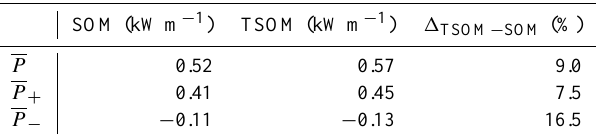
Table 4. Application of TSOM: assessment of the longshore flux of wave energy in shallow-water P . P is the mean over the 1979–2008 period accounting for the absolute value of P , P + is the mean of the positive P , and P − is the mean of the negative P , (cid:49) TSOM − SOM is the relative difference of values computed after TSOM with respect to values computed after